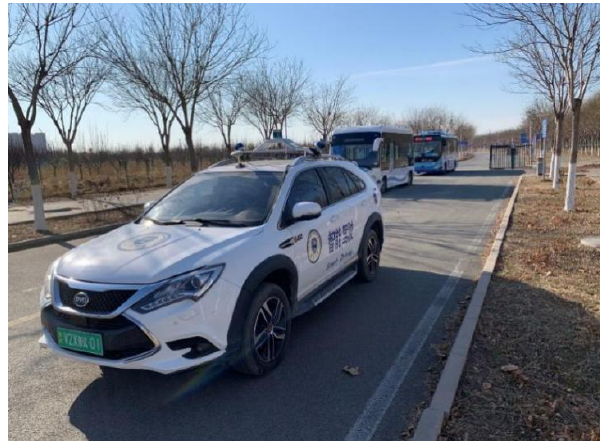
Figure 20. Automatic driving test field and test vehicle of Tianjin University.